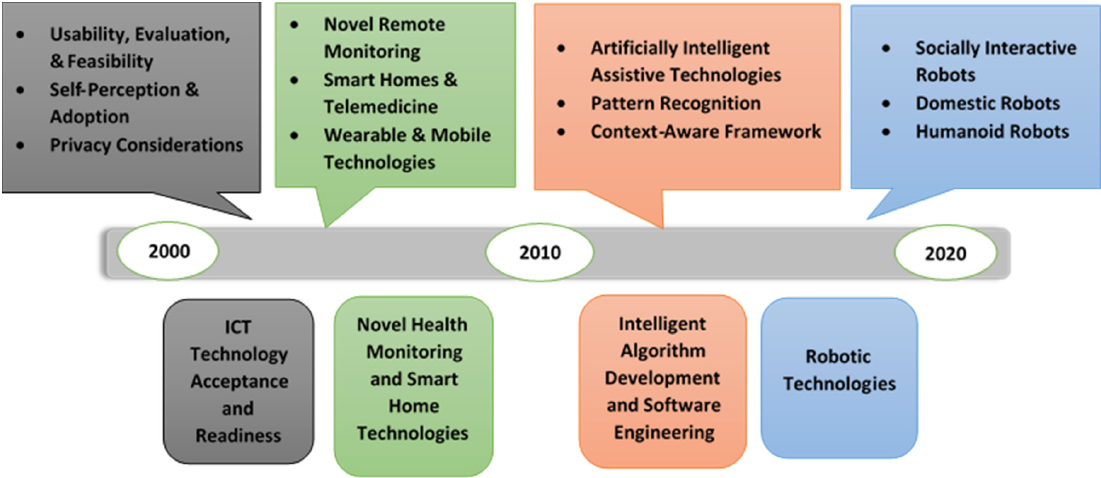
Figure 6. A detailed view of the development process of ICT solutions with its different aspects.